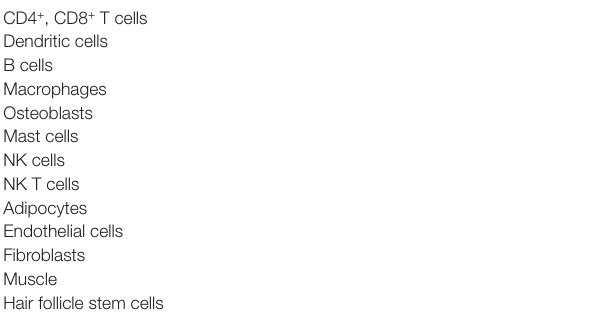
tAbLe 1 | Cellular targets for Foxp3 + T regulatory-mediated